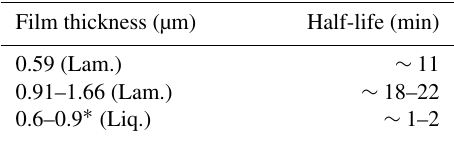
Table 1. The half-life of the films used in this study (to the nearest minute). Taken from individual model fits to the